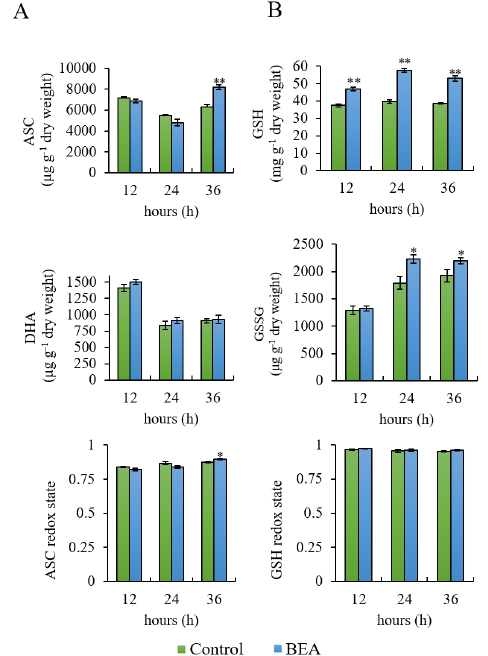
Figure 2. Ascorbate (ASC) (Panel A ) and glutathione (GSH) (Panel B ) pools in control and beauvericin (BEA) treated sample during 36 h of assay. Asterisks indicate values significantly different from the control at each time point, according to the Student’s t test with p < 0.05 (*) and p < 0.01 (**).